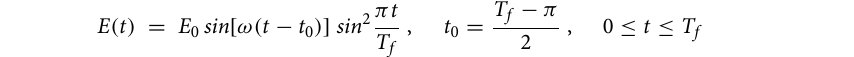
E sin t sin 2 π t 1.71 , ω( t 0 0 ) T f , ω = = [ − ] 180 ) correspond to different values of the cutoff =